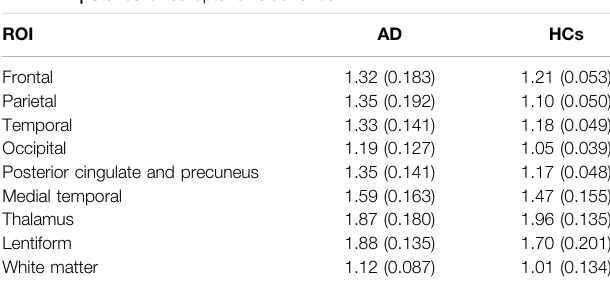
TABLE 2 | Standardized uptake value